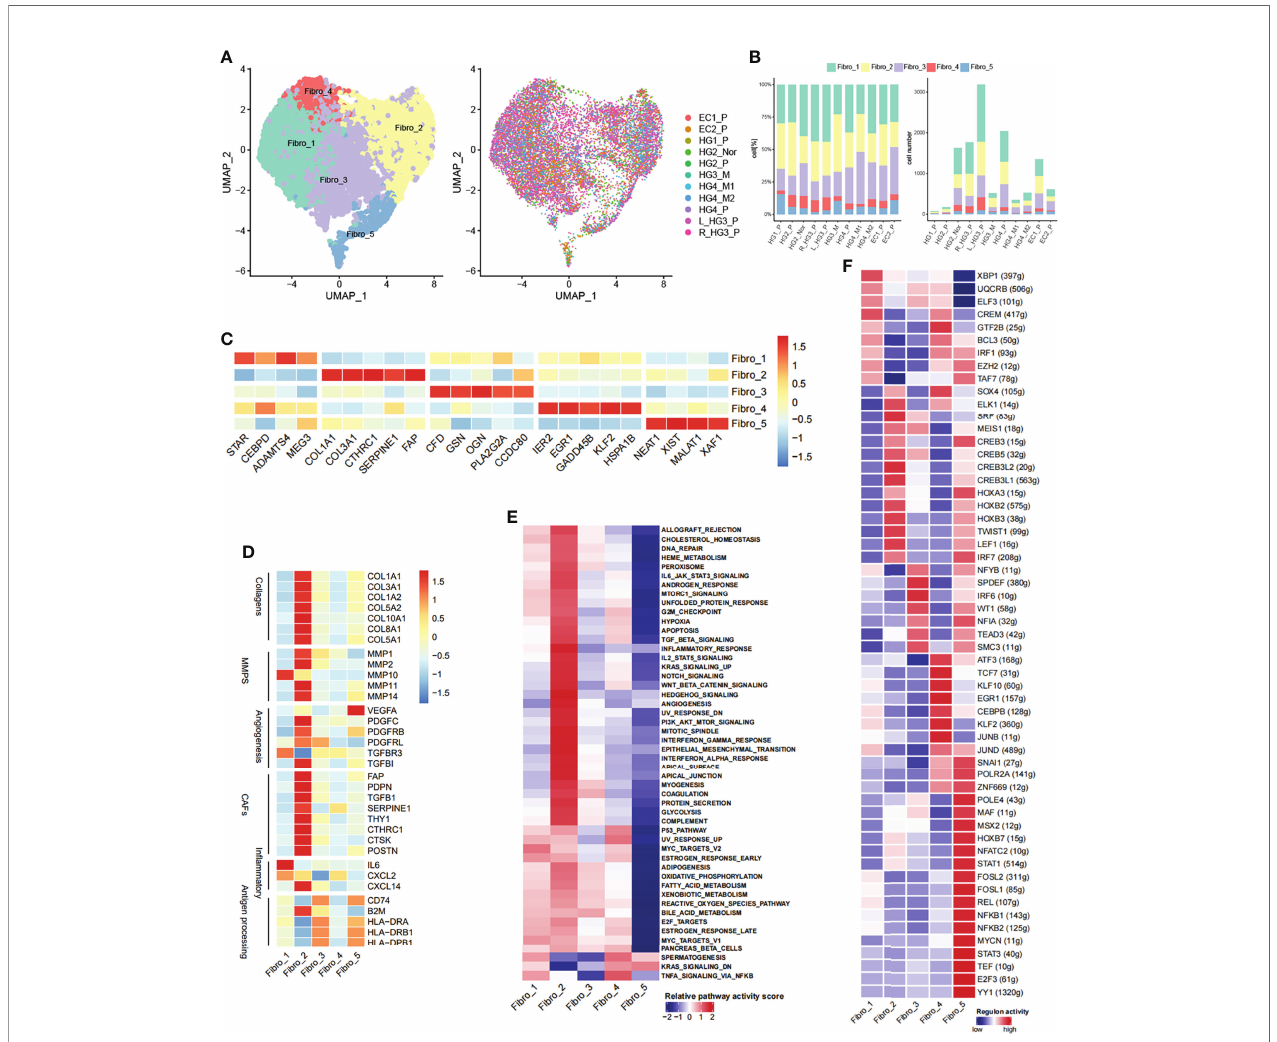
FIGURE 4 | Diversity of fi broblasts in HG_M. (A) The UMAP projection of 12,236 fi broblast cells of 11 samples from six patients (indicated by labels and colors). (B) Proportion and cell number of each fi broblast subtype in 11 samples. (C) Heatmap of marker genes expression. (D) Heatmap of functional gene sets. (E) GSVA analysis of differential pathways is scored per cell among fi ve fi broblast subsets. (F) Active regulons in each fi broblast ( Figure 4C ). The distribution of fi broblast sub-clusters in each tumor was varied ( Figure 4B ). In addition, comparisons based on hallmark gene sets of fi broblasts had been conducted. Fibroblasts from HG_M were more abundant in supporting tumor progress than HG_P, including angiogenesis, coagulation system, and EMT ( Figure S9D ). Fibroblasts from EC_P were more enriched in the structure formation of tissue than HG_P, such as myogenesis and adipogenesis, whereas in fl ammatory pathways including TNFA signaling via NF k B and in fl ammatory response more enriched in HG_P than EC_P ( Figure S9E ). Combined with the analysis of normal fallopian tubes (nFT) from previous studies (38, 39), we found that fi broblasts from HG_P were more abundant in supporting interferon-alpha/gamma response than HG_nor/nFT while estrogen responses early activity was more active in HG_nor/ nFT than HG_P ( Figure S9F ).